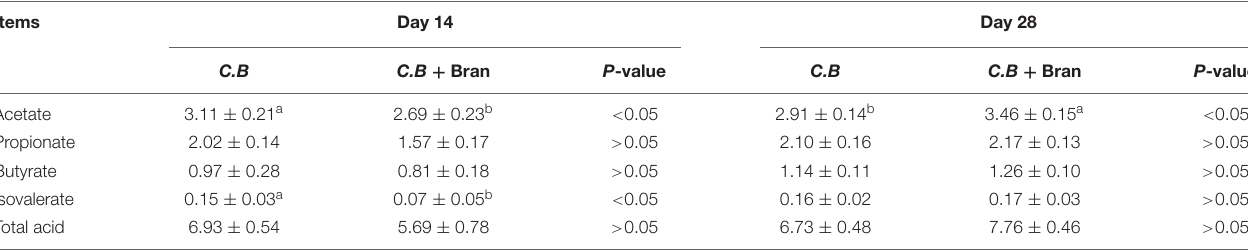
TABLE 3 | Effect of dietary C.B and C.B + corn bran inclusion on concentration of fecal SCFAs (mg/g feces) 1